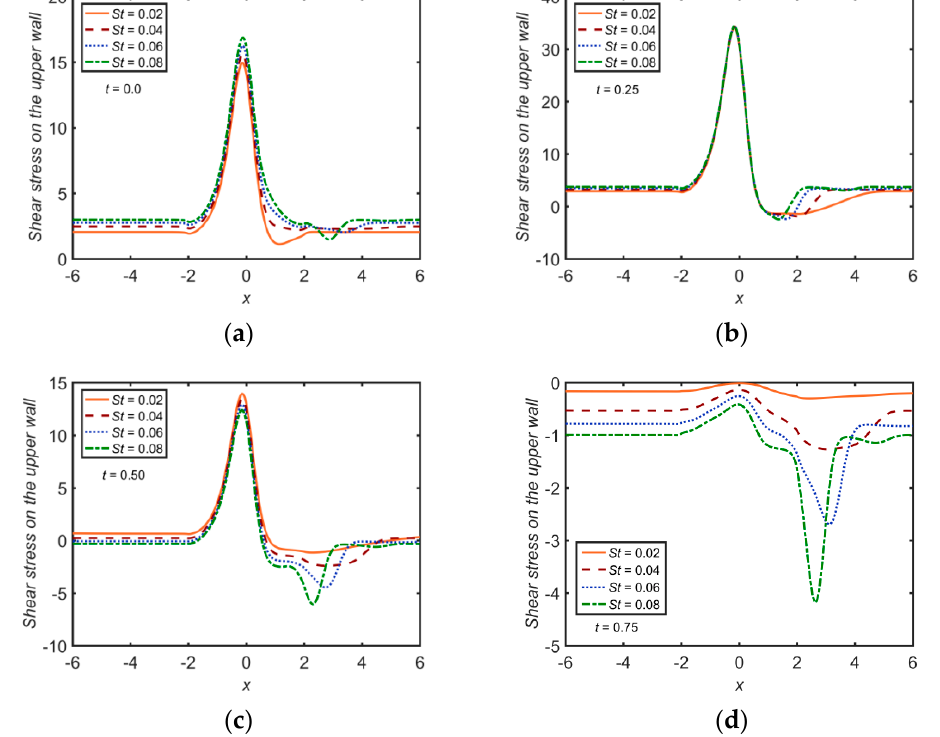
Figure 5. The WSS distribution on varying the values of 𝑆𝑡 with 𝑀 = 5 , 𝐾 = 0.6 , and 𝑅𝑒 = 700 at ( a ) 𝑡 = 0 , ( b ) 𝑡 = 0.25 , ( c ) 𝑡 = 0.50 , and ( d ) 𝑡 = 0.75 .